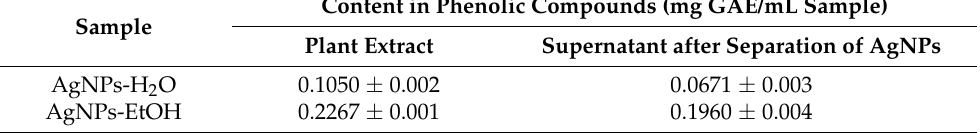
Table 1. Content in phenolic compounds of the plant extract and of the supernatant obtained after AgNPs separation.